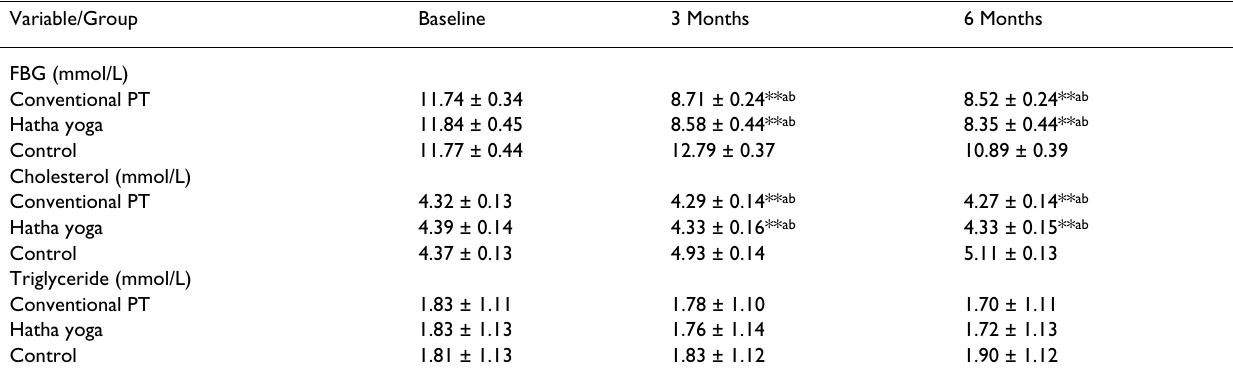
Table 2: Comparison of FBG, cholesterol and triglyceride concentrations amongconventional PT exercise, Hatha yoga exercise and control type 2 diabeticpatients over a 6-month period Variable/Group